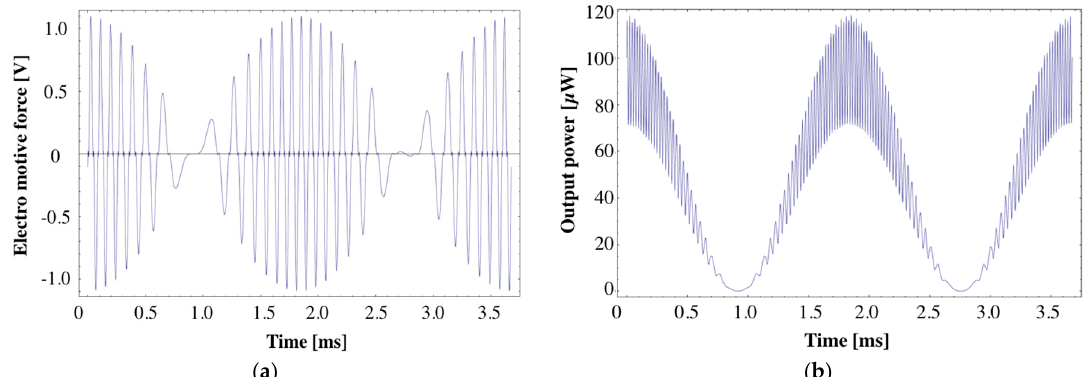
Figure 5. Simulated waveforms: ( a ) Electro motive force; ( b ) Harvesting output